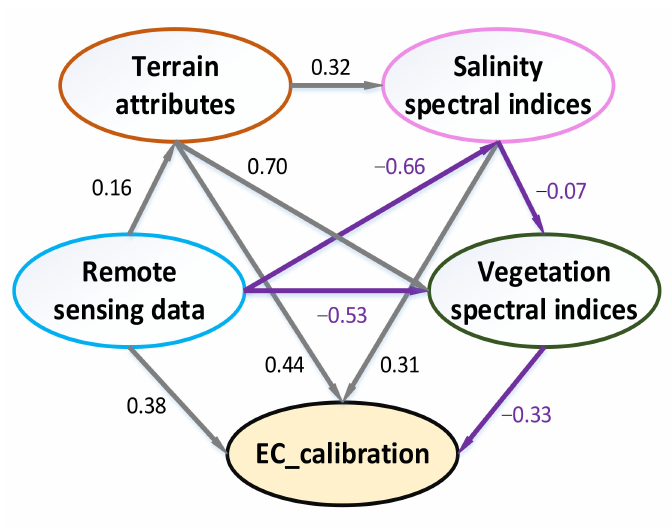
Figure 7. Path analysis of training